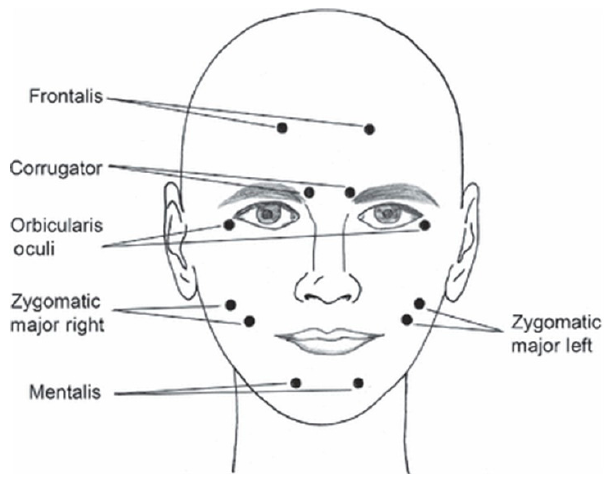
Sensors 2020 , 20 , x FOR PEER REVIEW Figure 11. Facial electromyography [149]: location of electrodes. Figure 11. Facial electromyography [149]: location of electrodes.